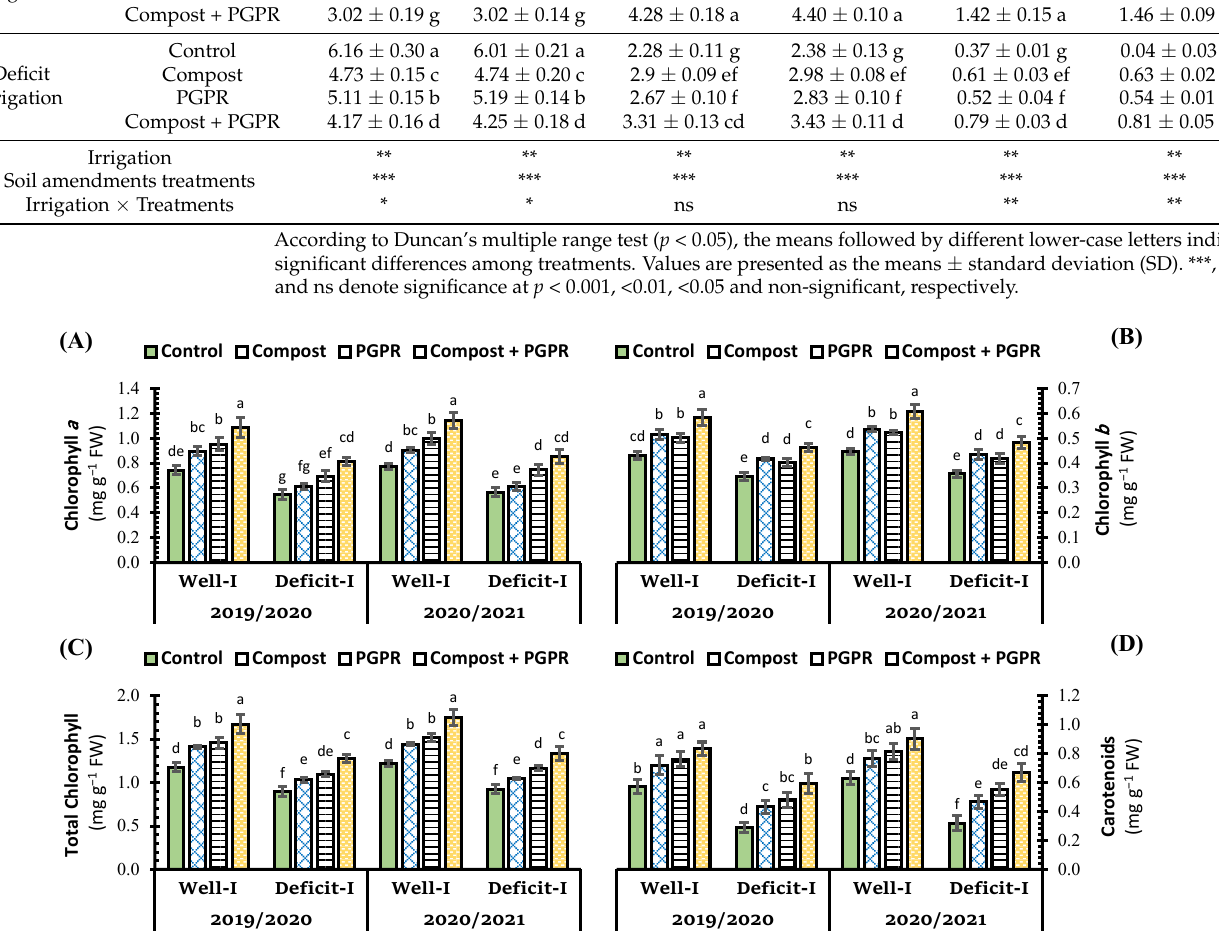
Figure 1. Influence of soil amendment with compost and plant growth-promoting rhizobacte- ria (PGPR) on the concentration of photosynthetic pigments ( A ) chlorophyll a , ( B ) chlorophyll b , ( C ) total chlorophyll, and ( D ) carotenoids in the leaves of wheat plants grown in salt-affected soil and deficit irrigation in contrast to well irrigation. The error bars present the values of standard deviation. According to Duncan’s multiple range test, the same lower-case letters above columns are not significantly different ( p <